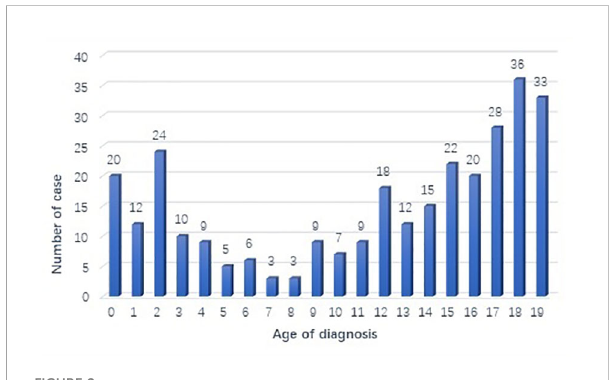
FIGURE 2 Number of primary lung cancer diagnosed each age group in SEER